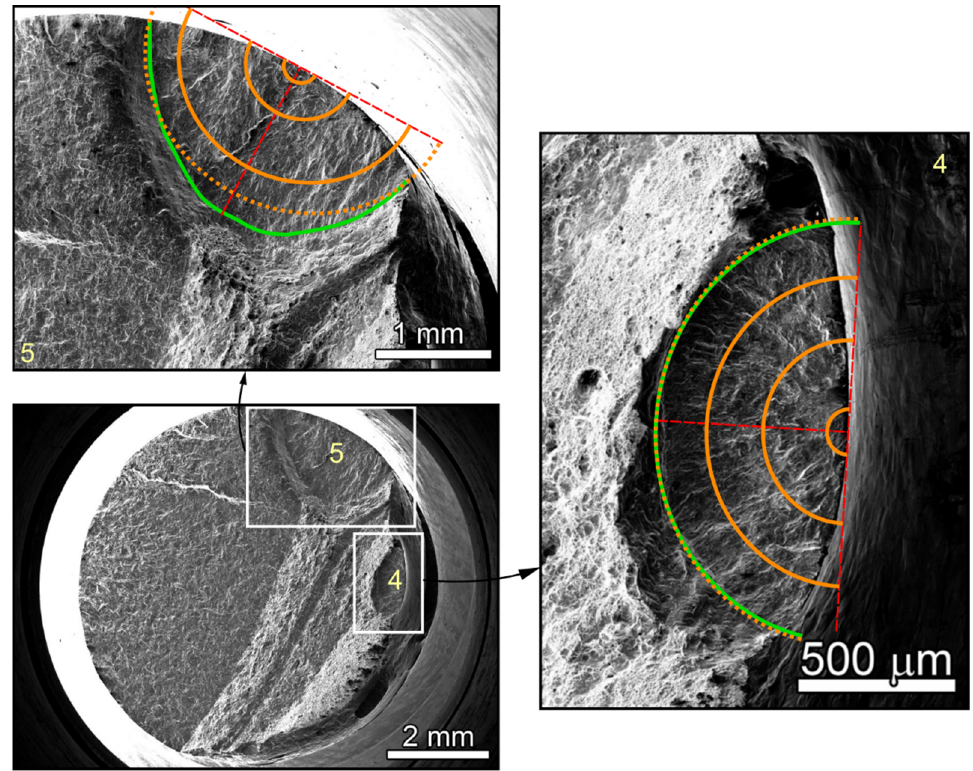
Figure 13. Fracture surface of 304L cycled at ε a = 0.4%. Two developed cracks are notable and denoted by numbers 4 and 5. The shapes of both cracks 4 and 5 were used for comparison with numerically predicted crack front shapes.